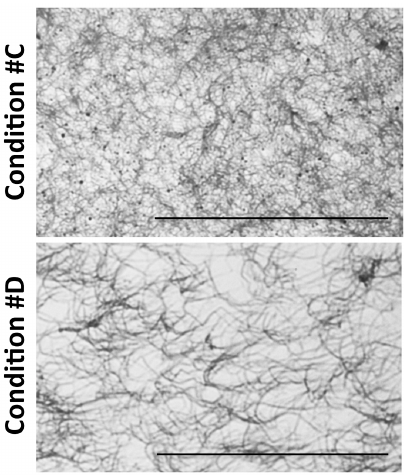
Figure 2. Light microscopy of collagen gels. The fibrillar organization of collagen gels is visualized by light microscopy after Anilin blue staining. Images correspond to the four experimental conditions as in Figure 1. Bar: 100 μ m.